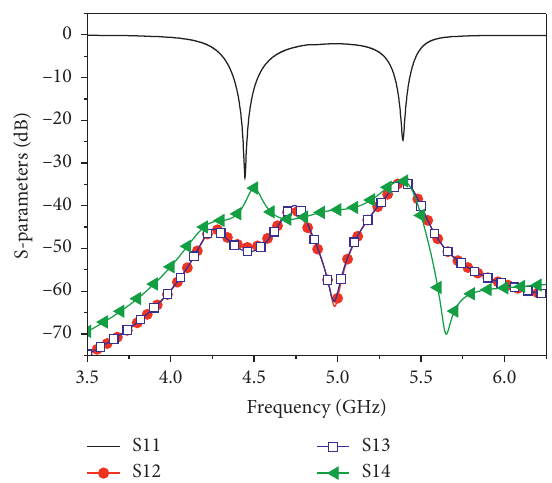
Figure 10: Simulated S-parameters of MIMO antenna with SNLs.